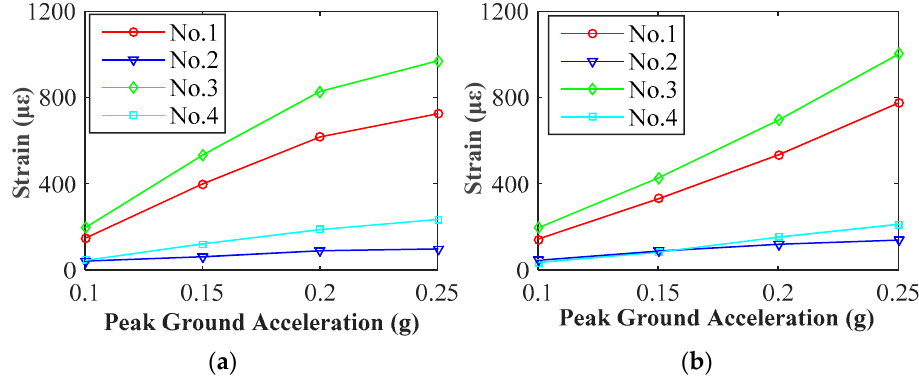
Figure 13. The peak value of the strain response on measuring point S1 for various seismic accelerations. ( a ) RSN169_IMVPALL and ( b ) RSN1116_KOBE. ( a ) RSN169_IMVPALL and ( b )